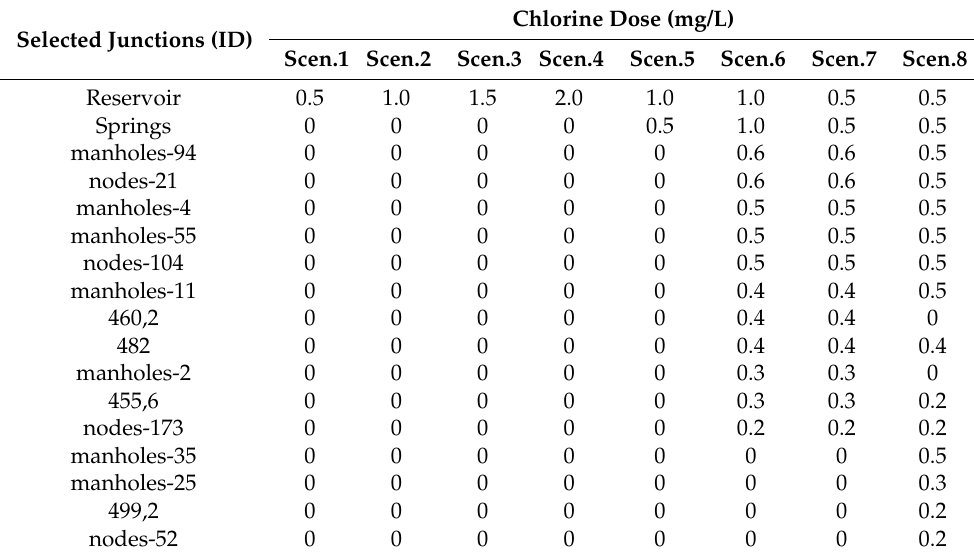
Table 3. Chlorine doses (mg/L) applied at booster stations for scenario A. Selected Junctions